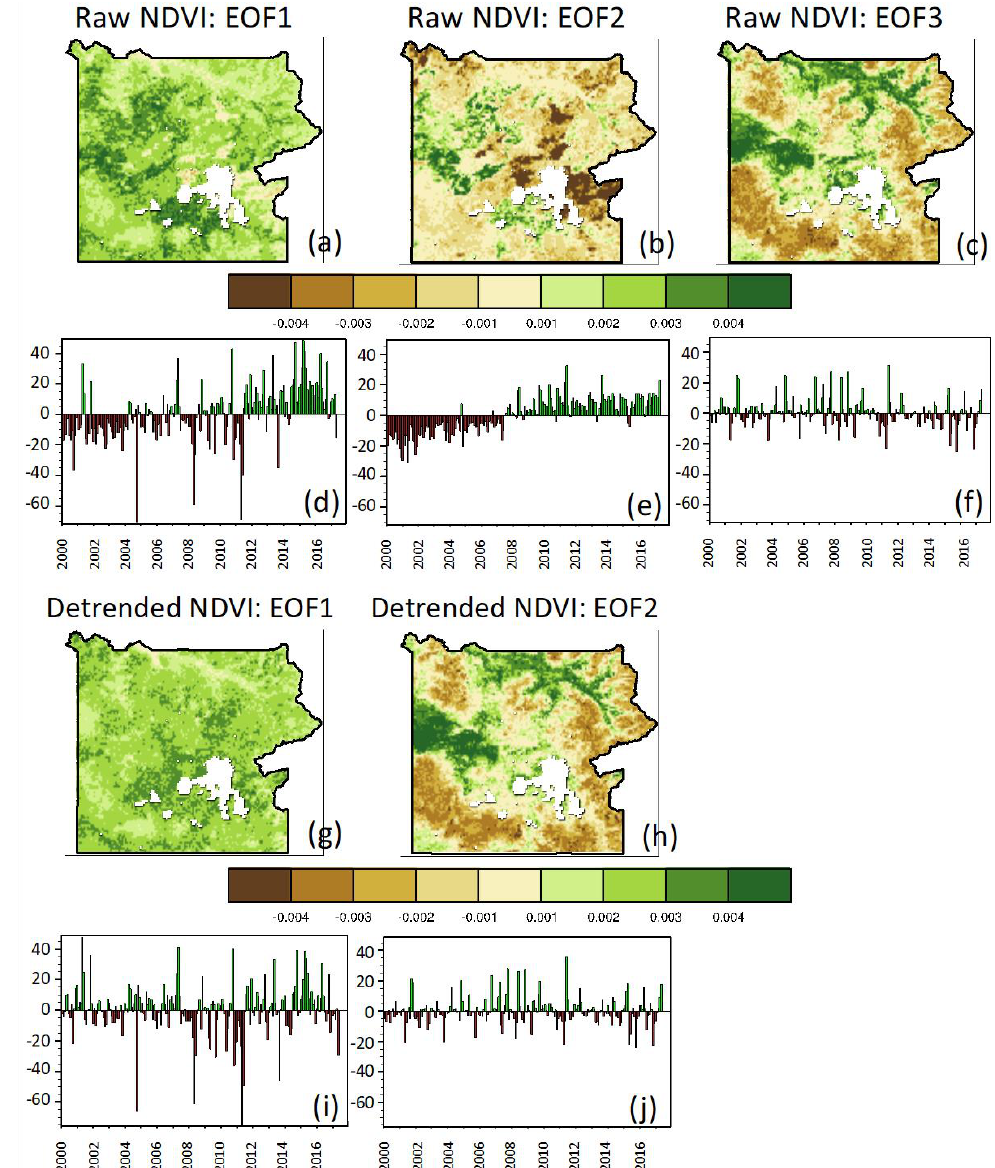
Figure 7. ( a – c, g – h ) Spatial pattern and ( d – f, i – j ) time-series of ( a,d,g,i ) empirical orthogonal function mode 1 (EOF1), ( b,e,h,j ) EOF2, and ( c,f ) EOF3 of year-round monthly Moderate Resolution Imaging Spectroradiometer ( MODIS) Normalized Difference Vegetation Index (NDVI) anomalies across Yellowstone National Park during 2000 – 2017, both ( a – f ) without and ( g – j ) with linear detrending applied to the NDVI data. EOF3 of the detrended NDVI anomalies is excluded here, as it is a noisy, incoherent spatial pattern with trivial explained variance. The explained variance associated with each eigenvalue in EOF1-3 was 31.0%, 13.1%, and 7.7%, respectively, for the un-detrended data and 31.8%, 9.3%, and 3.4%, respectively, for the detrended data. The explained variance for each EOF mode was computed by dividing that mode’s eigenvalue by the sum of all modes’ eigenvalues and multiplying by 100%, where an eigenvalue expresses how much of the variance can be explained by its associated eigenvector. Next, attention shifts to the topic of interannual to decadal variability in vegetation productivity. An EOF analysis was performed on year-round monthly NDVI anomalies during 2000 – 2017, rather